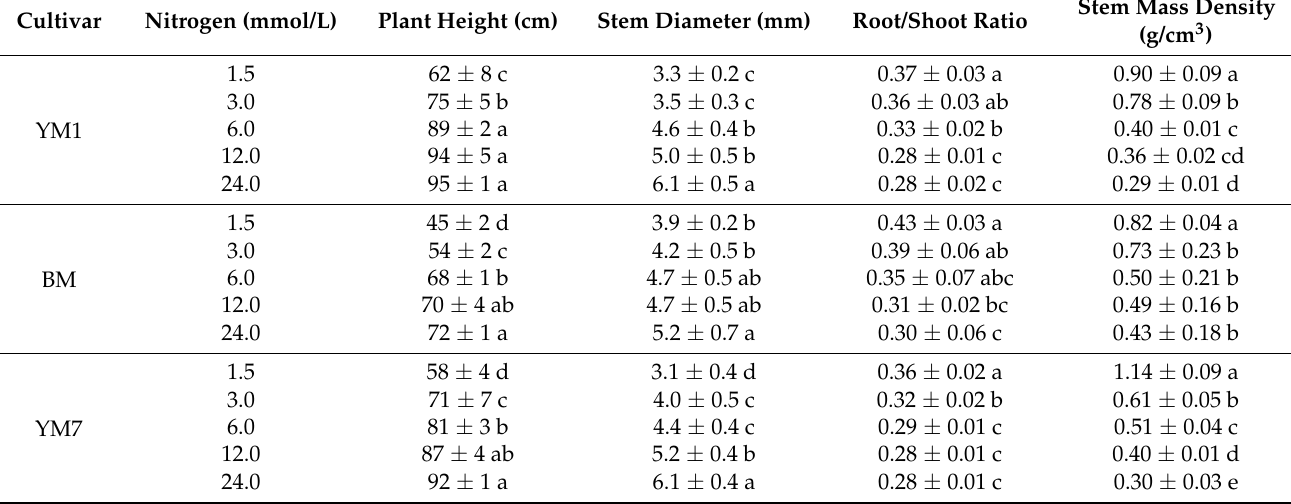
Table 1. Effect of N treatments on the hemp growth